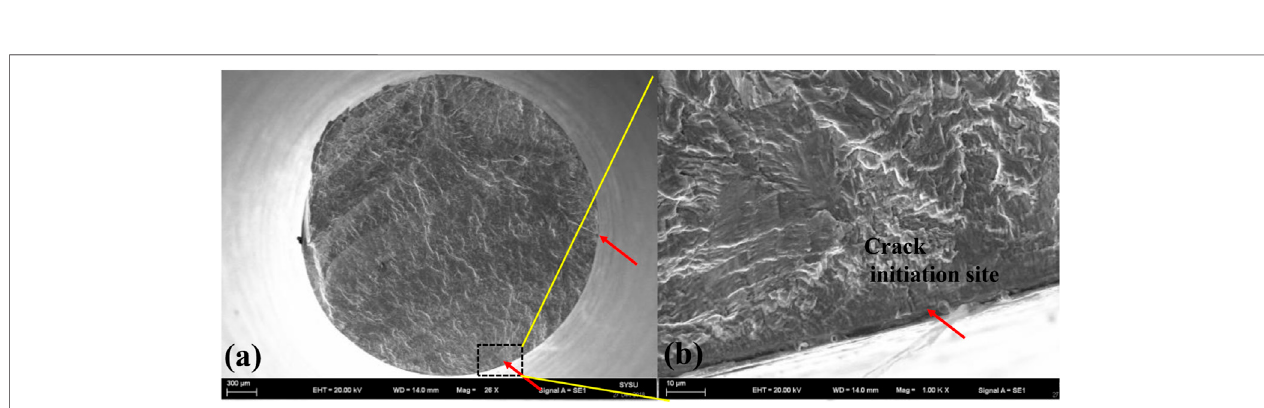
FIGURE 5 | Fracture surface of the specimen (LBW) tested at 340 MPa failed at 1.84 × 10 5 cycles. (A) overview of the fracture surface and (B) enlargement of the marked rectangle in (A) .